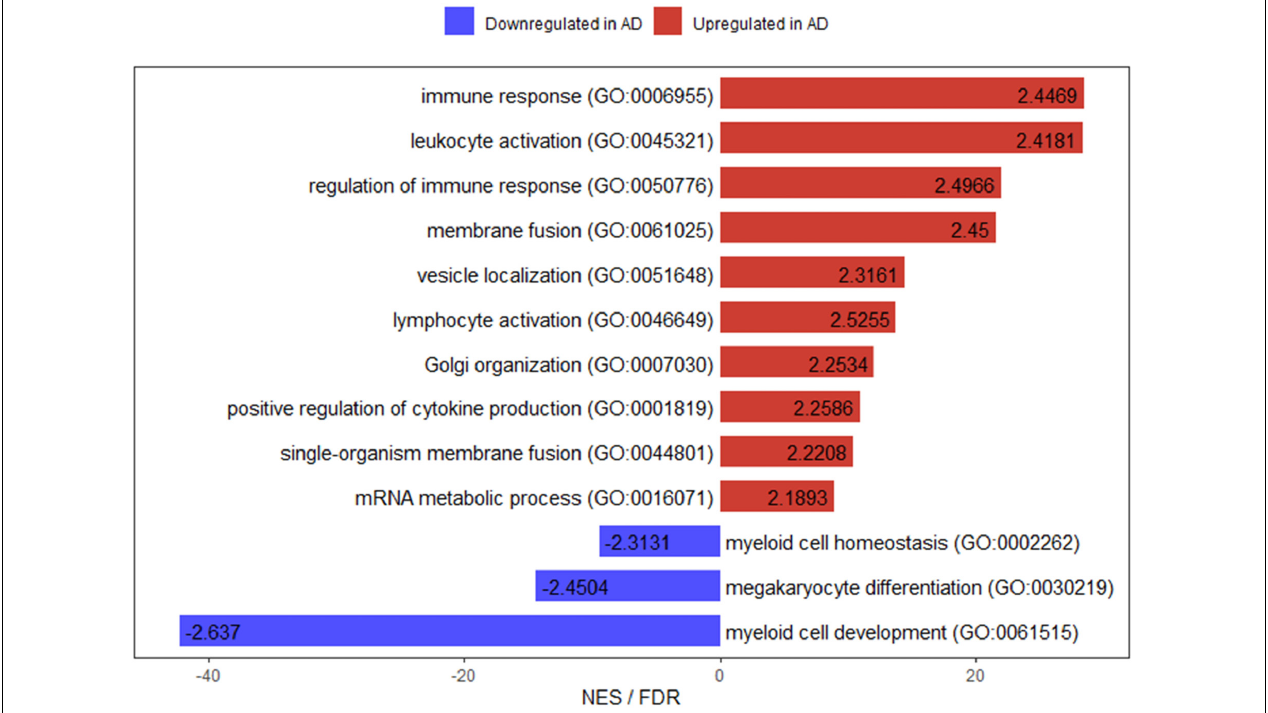
FIGURE 4 | Bar plot for enriched gene ontology categories with FDR < 0.25 from GSEA of our eQTL analysis results. The numbers on the bars are the normalized enrichment scores for the corresponding gene ontology categories. NES: normalized enrichment